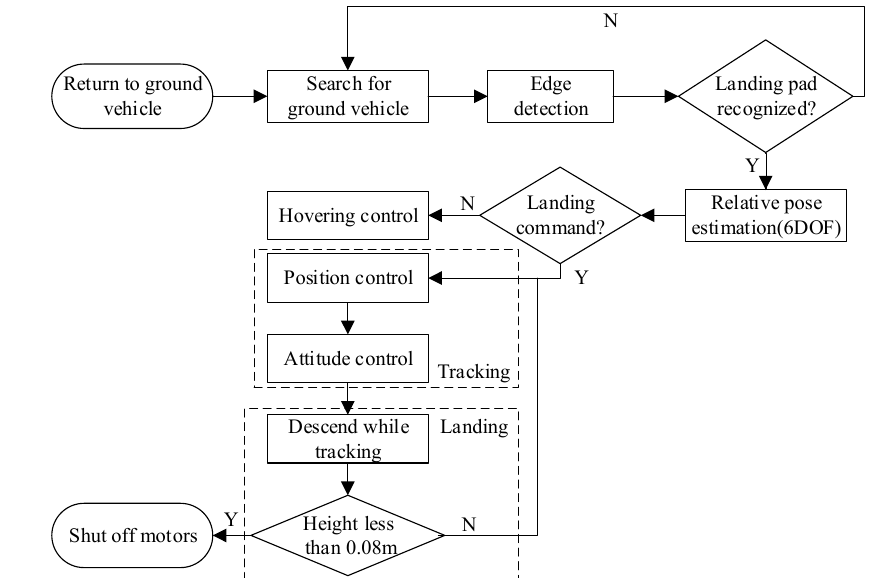
Figure 6. Overview of the proposed autonomous landing system.